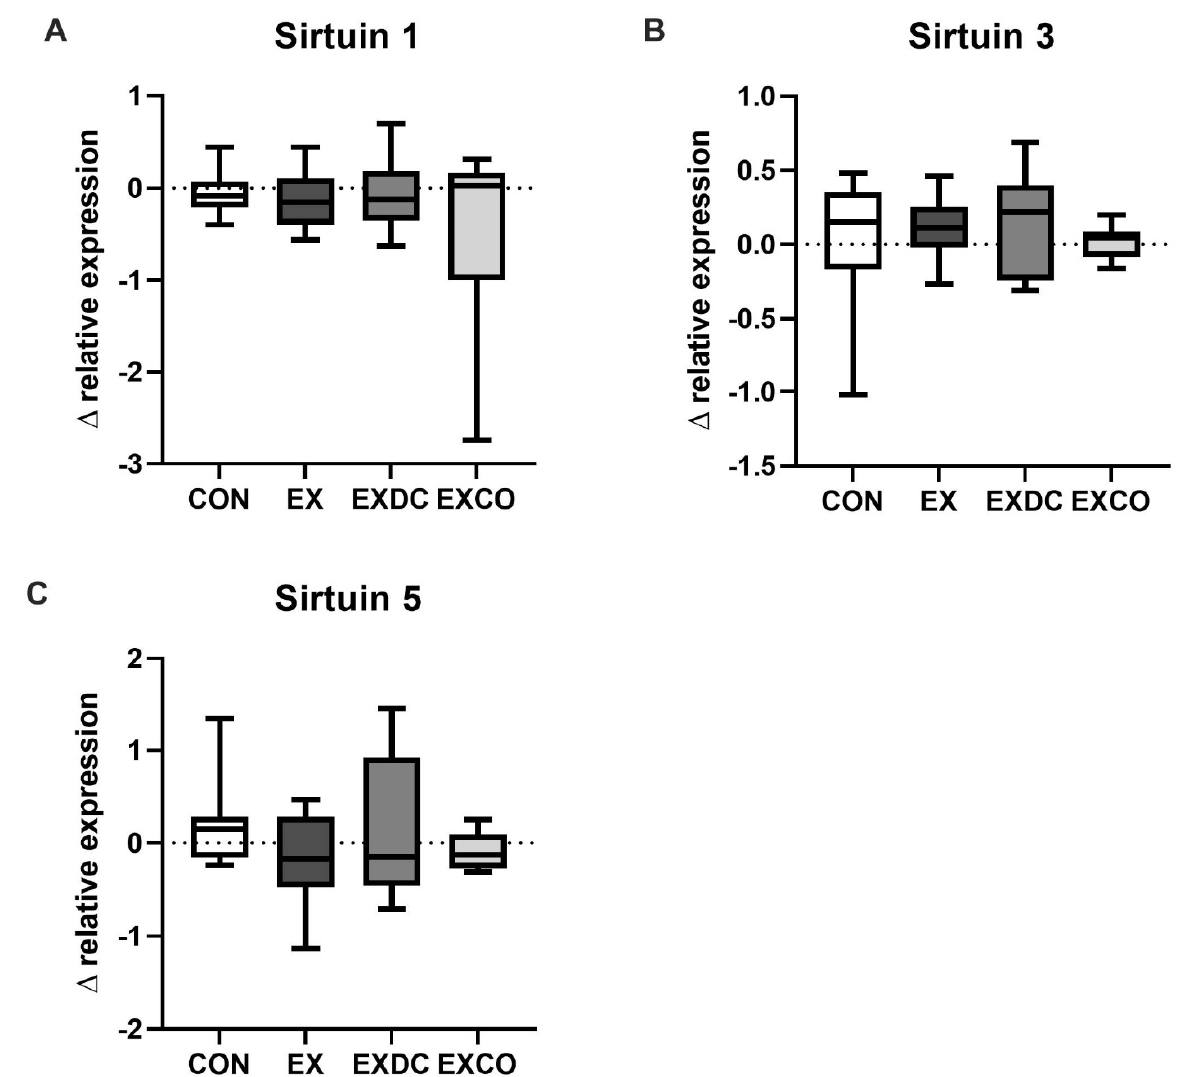
Figure 3. Changes in the relative expression of SIRT1, SIRT3 and SIRT5. Changes were calculated as the difference of relative expression after (post) and before (pre) the intervention for the four study groups, CON, EX, EXDC and EXCO, for SIRT1 ( A ), SIRT3 ( B ) and SIRT5 ( C ). Data are shown as median ± quartiles and extremes; n = 6–12. To assess statistical differences a Kruskal–Wallis test was conducted.